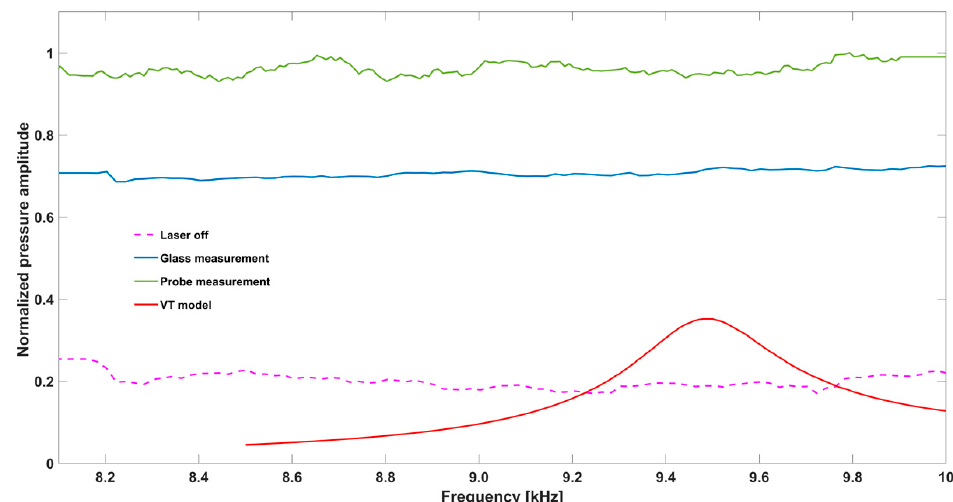
Figure 7. Experimental frequency response in the low frequency range. The pink plot is the offset level when the laser is turned off, the blue plot is the measurement with the glass window, the green plot is with the graphite probe while the red plot is the simulation from the viscothermal model.